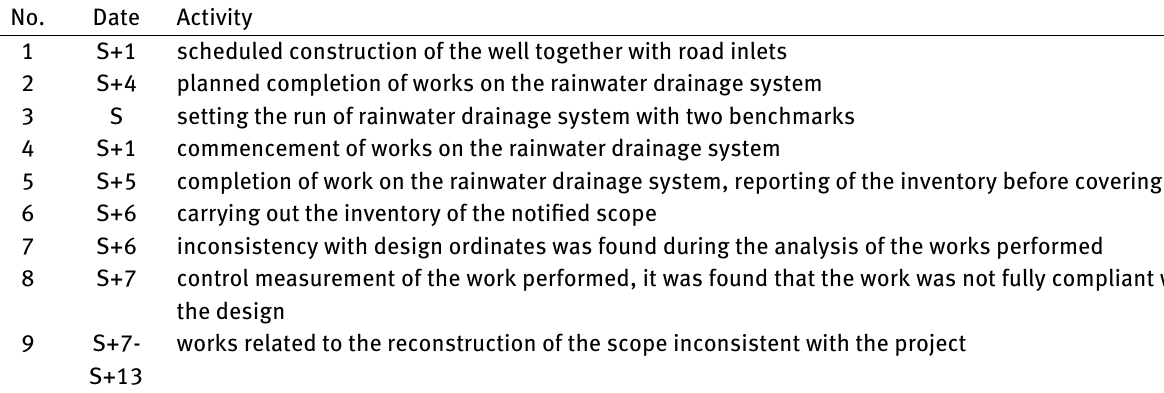
Table 2: Separate part of the schedule in which the R2 factor occurred, Source: own elaboration.